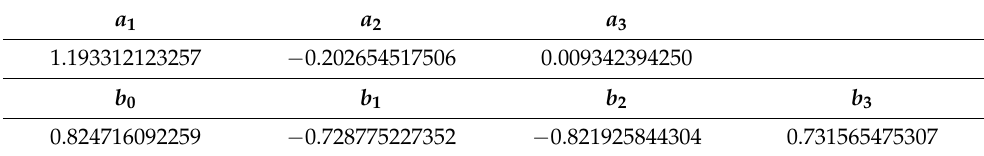
Table 4. Digital controller